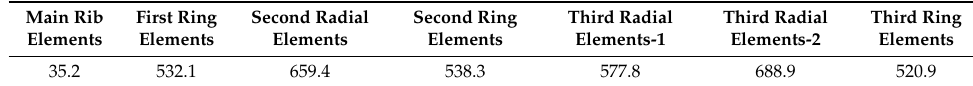
Table 3. The cross-section of the replacement elements and their corresponding damage degrees.